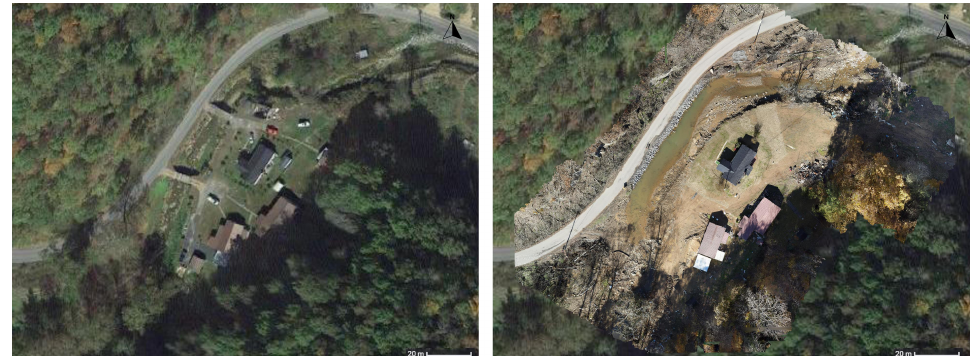
Figure 6. A comparison of pre-flood satellite imagery to post-flood imagery. The image on the left shows Google Maps satellite imagery. The image on the right shows the post-flood orthophoto overlaid on the satellite image in GIS (Geographic Information System) software.